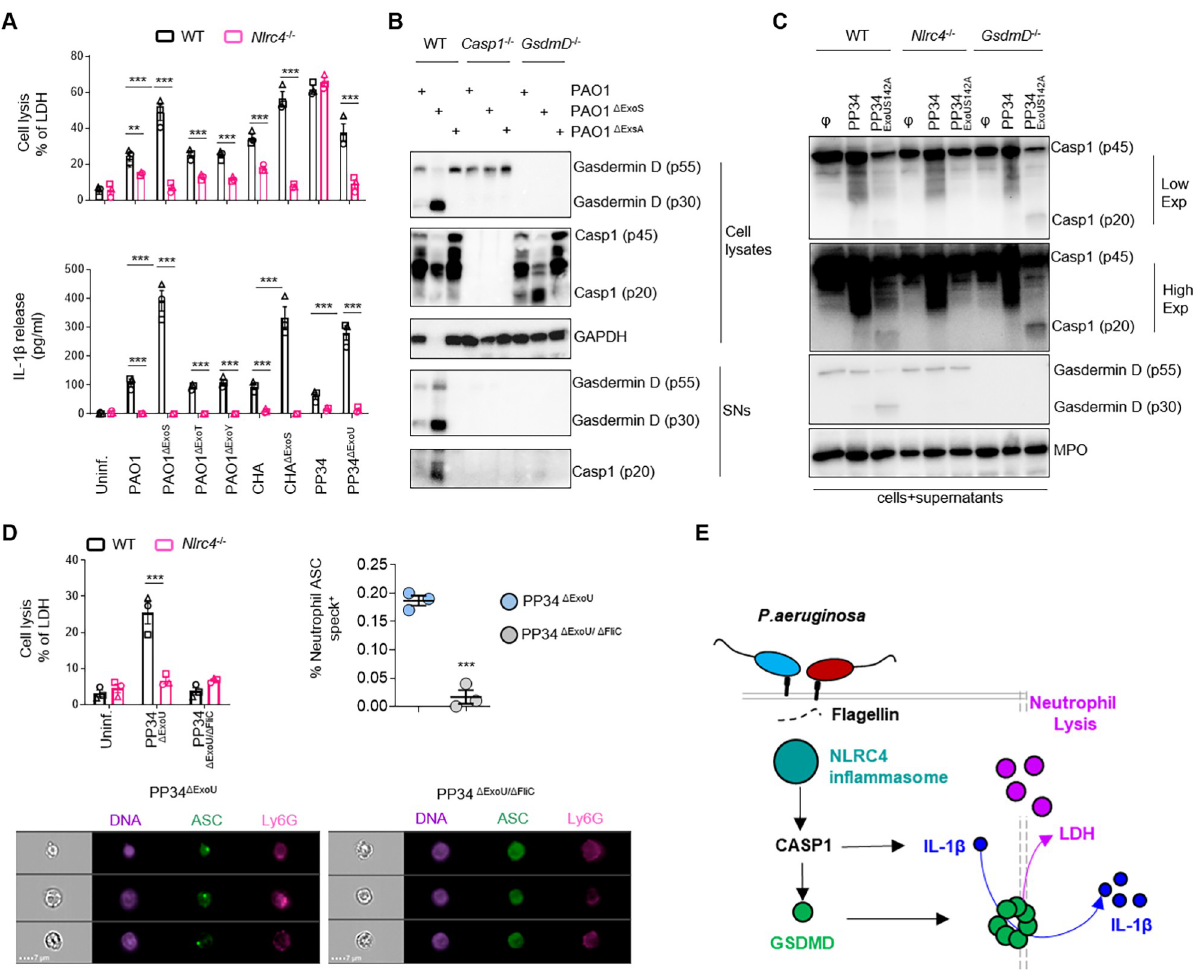
Fig 2. P . aeruginosa infection engages a canonical NLRC4-Caspase-1-Gasdermin D-dependent pyroptosis axis in neutrophils. A. Measure of cell lysis (release of LDH) and IL-1 β release in WT or Nlrc4 -/- murine Bone Marrow Neutrophils (BMNs) infected for 3 hours with Pseudomonas aeruginosa PAO1, CHA and PP34 strains and their isogenic mutants lacking T3SS-derived toxins ExoS, ExoY, ExoT or ExoU) at a multiplicity of infection (MOI) of 10 (PAO1 and CHA strains) and 2 (PP34 strains). �� p � 0.01 ��� p � 0.001, Two-Way Anova with multiple comparisons. Values are expressed as mean ± SEM. Graphs show combined values from three independent experiments. B. Immunoblotting of GAPDH, pro-forms of Caspase-1 (p45) and Gasdermin-D (p55), processed Caspase-1 (p20) and Gasdermin D (p30), in WT, Casp1 -/- and GsdmD -/- in cell lysates and cell supernatants (SNs) of BMNs infected for 3 hours with PAO1 or its isogenic mutants lacking T3SS expression (PAO1 Δ ExsA ) or ExoS (PAO1 Δ ExoS ) at a multiplicity of infection (MOI) of 10. Immunoblots show lysates and supernatants from one experiment performed three times. C. Immunoblotting of Myeloperoxidase (MPO), pro-forms of Caspase-1 (p45) and Gasdermin-D (p55), processed Caspase-1 (p20) and Gasdermin D (p30), in WT, Nlrc4 -/- and GsdmD -/- BMNs infected for 3 hours with P . aeruginosa strain PP34 or its isogenic mutant lacking ExoU activity (PP34 ExoUS142A ) at a multiplicity of infection (MOI) of 2. Immunoblots show combined lysates and supernatants from one experiment performed three times. D. Measure of cell lysis (release of LDH) in WT and Nlrc4 -/- BMNs infected for 3 hours with P . aeruginosa mutant strains PP34 Δ ExoU or PP34 Δ ExoU/ Δ FliC at a multiplicity of infection (MOI) of 2 and Imagestream experiments and quantifications of in vivo formation of ASC specks in bronchoalveolar (BALs) neutrophils from ASC-Citrine mice intranasally infected with 1.10 5 PP34 Δ ExoU or PP34 Δ ExoU/ Δ FliC for 6 hours. The gating strategy used to evaluate inflammasome activation in neutrophils was performed as follow: (i) a gate was set on cells in focus [Cells in Focus] and (ii) a sub-gate was created on single cells [Single Cells]. Then we gated first on (iii) LY6G+ Neutrophils [LY6G+] and second on (iv) ASC-citrine+ and Hoechst+ cells [Hoechst+/ASC-Citrine+] within LY6G+ population. (v) To distinguish cells with active (ASC-speck) versus inactive inflammasome (Diffuse ASC), we plotted the Intensity with the area of ASC-citrine. This strategy allows to distinguish cells with active inflammasome that were visualized and quantified. For Imagestream experiments ��� p � 0.001, T-test with Bonferroni correction. Values are expressed as mean ± SEM. Graphs show one experiment representative of two independent experiments. For neutrophil in vitro experiments, ��� p � 0.001, Two-Way Anova with multiple comparisons. Values are expressed as mean ± SEM. Graphs show combined values from three independent experiments. E. Overview of the importance of the NLRC4 inflammasome at driving neutrophil pyroptosis in response to various Pseudomonas aeruginosa strains.